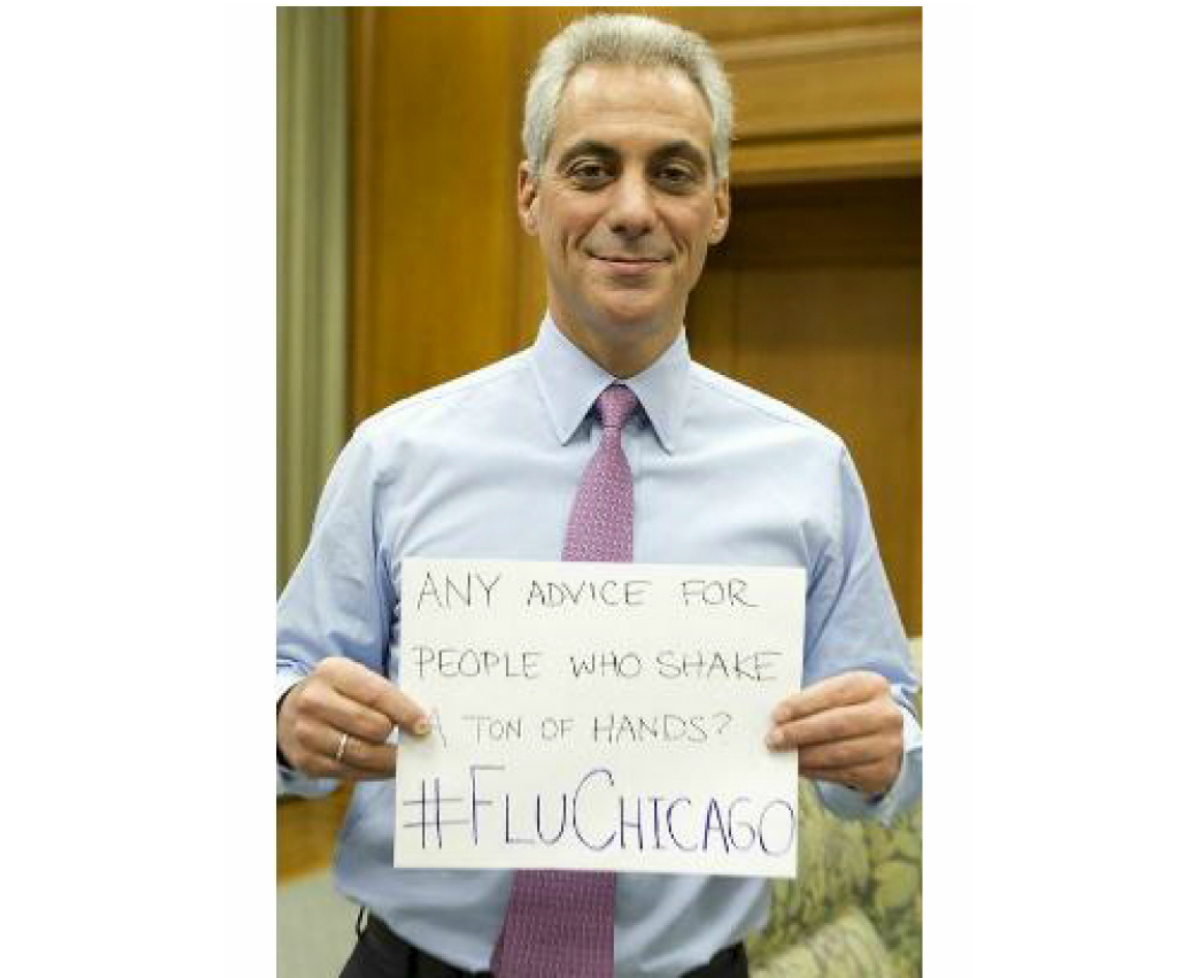
Figure 1. Chicago mayor Rahm Emanual participating in the #FluChicago 2013 Twitter chat about flu prevention with @ChiPublicHealth during flu season (Photo from Chicago Mayor’s Office, @ChicagosMayor